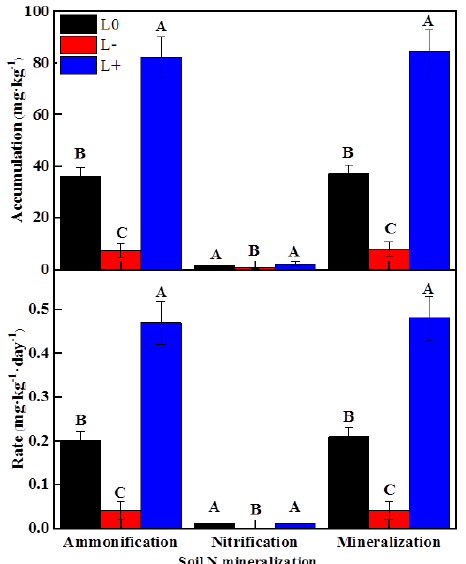
Figure 7. Soil net N mineralization accumulation and rate of di ff erent litter manipulations in 0–20 cm